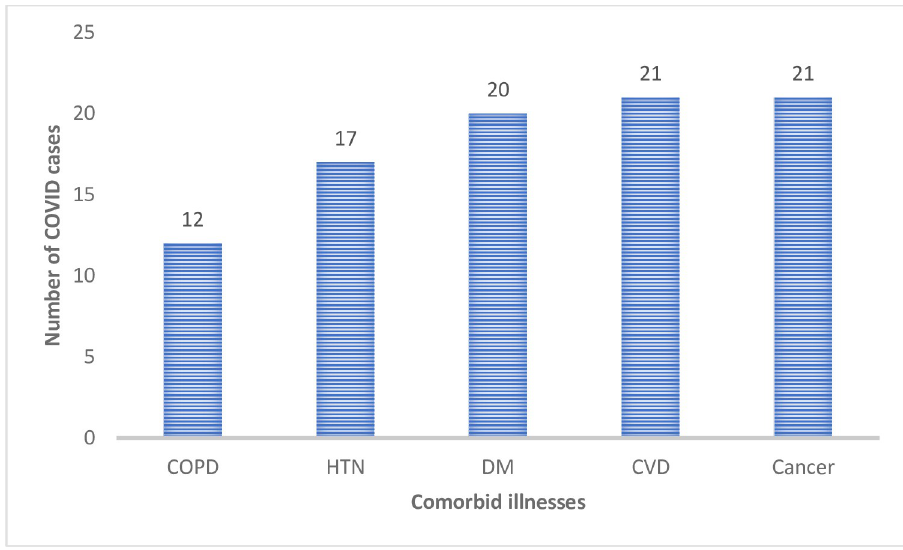
Fig 1. Co-morbidity among COVID-19 patients admitted to the hospital. CVD, Cardiovascular disease, COPD, Chronic obstructive pulmonary disease, DM, Diabetes Mellitus, HTN, Hypertension.